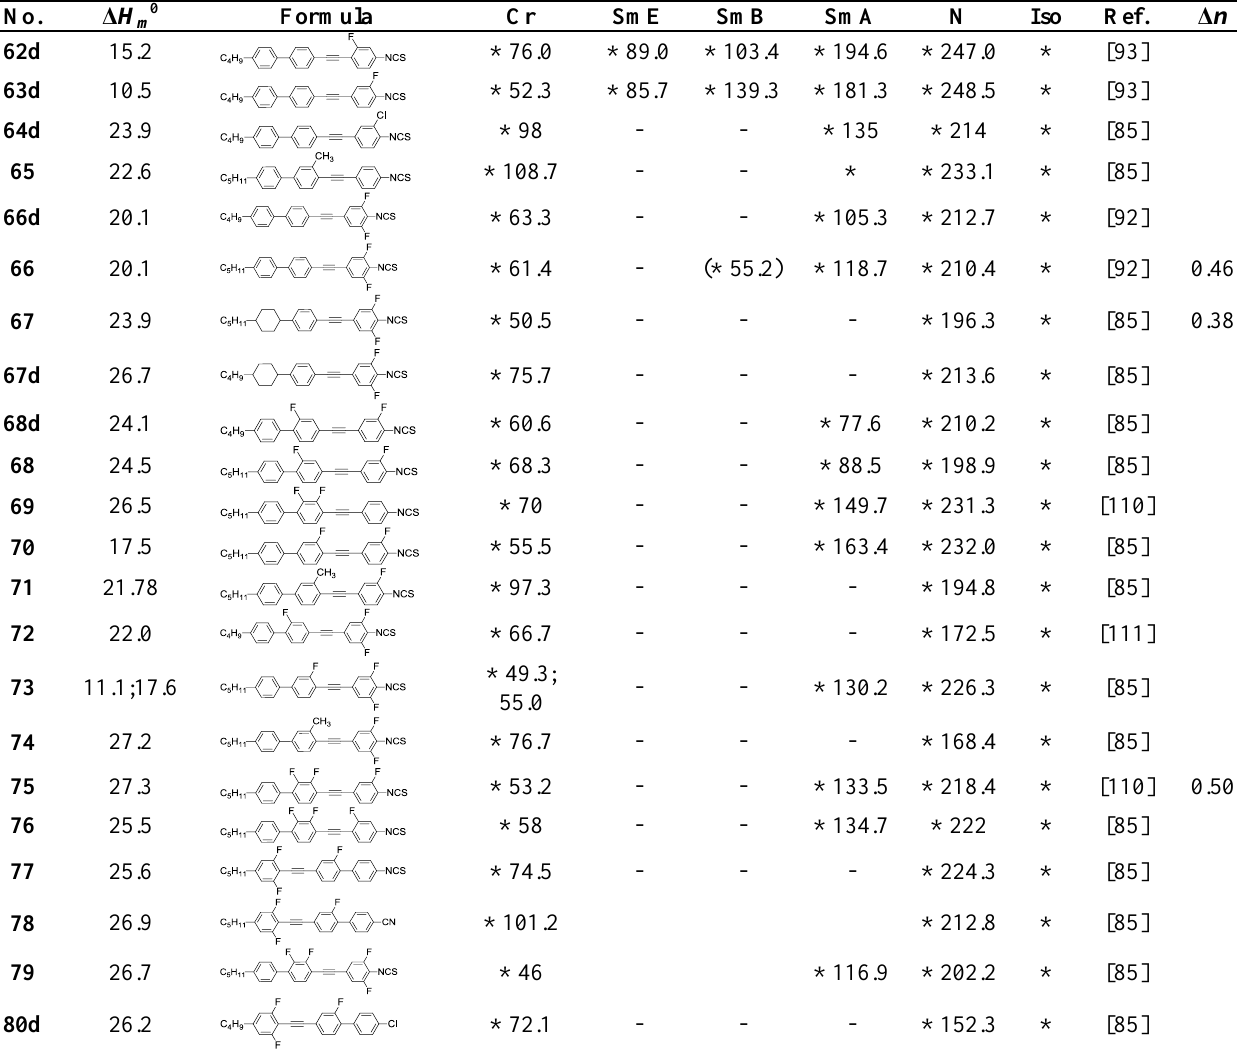
Table 10. Influence of lateral substitutions on mesogenic properties of alkyl phenyltolanes. Phase transition temperatures [°C] and melting enthalpies